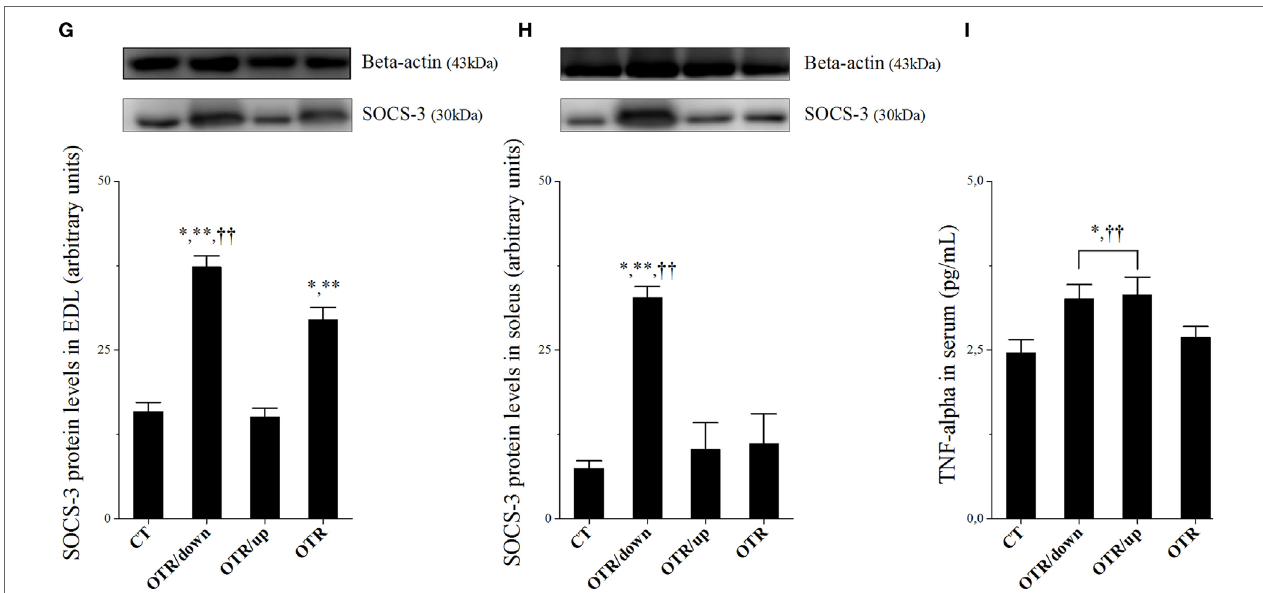
FigUre 1 | Protein levels (arbitrary units) of interleukin 1beta (IL-1 β ) in extensor digitorum longus (EDL) (a) , soleus (B) , and serum (c) ; IL-6 in EDL (D) , soleus (e) , and serum (F) ; SOCS-3 in EDL (g) and soleus (h) ; tumor necrosis factor alpha (TNF- α ) in serum (i) . Data correspond to mean ± standard error (SE) of n = 6. Control (CT): sedentary mice. OTR/down: overtrained by downhill running. OTR/up: overtrained by uphill running. OTR: overtrained by running without inclination. * P < 0.05 vs. CT; ** P < 0.05 vs. OTR/up; †† P < 0.05 vs.